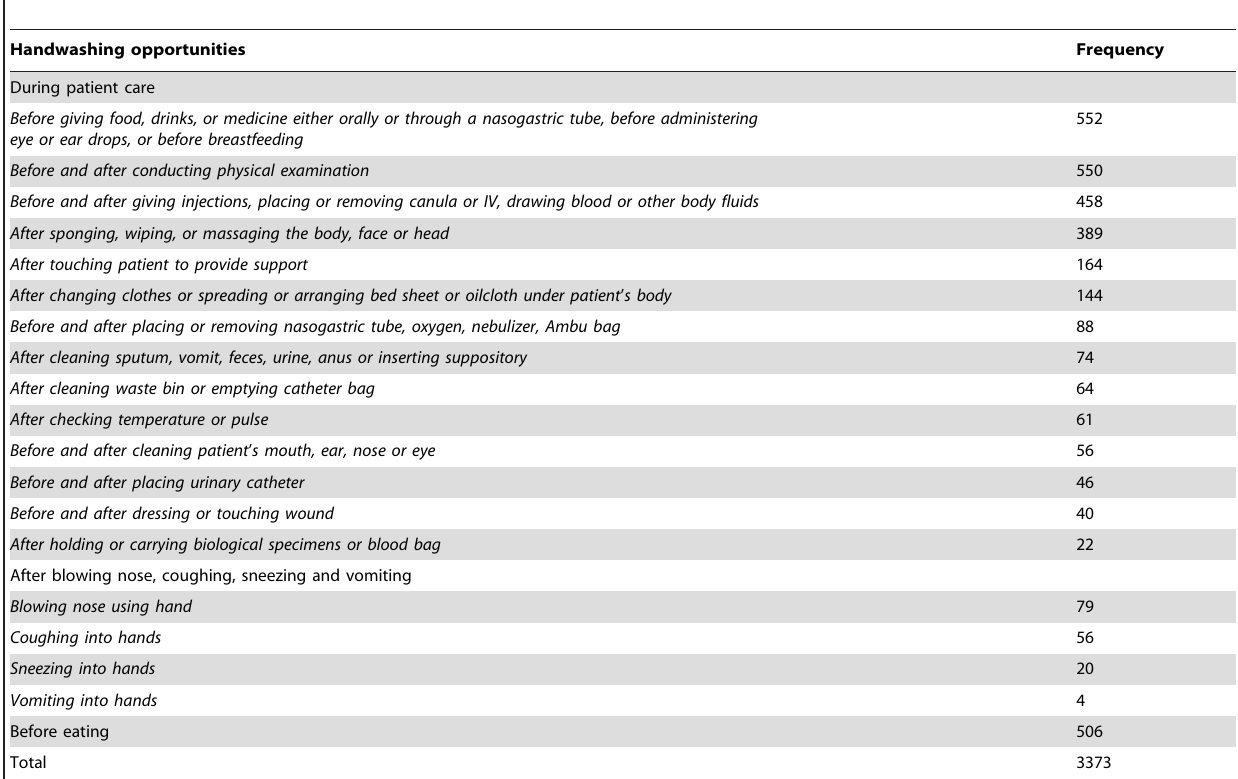
Figure 2. Median people present per 10 m 2 by category of person in three hospitals, 2007. Detailed legend: Median number of people present per 10 m 2 by category of person in the three hospitals, 2007. doi:10.1371/journal.pone.0089085.g002 Table 3. Handwashing opportunities observed in three hospitals,